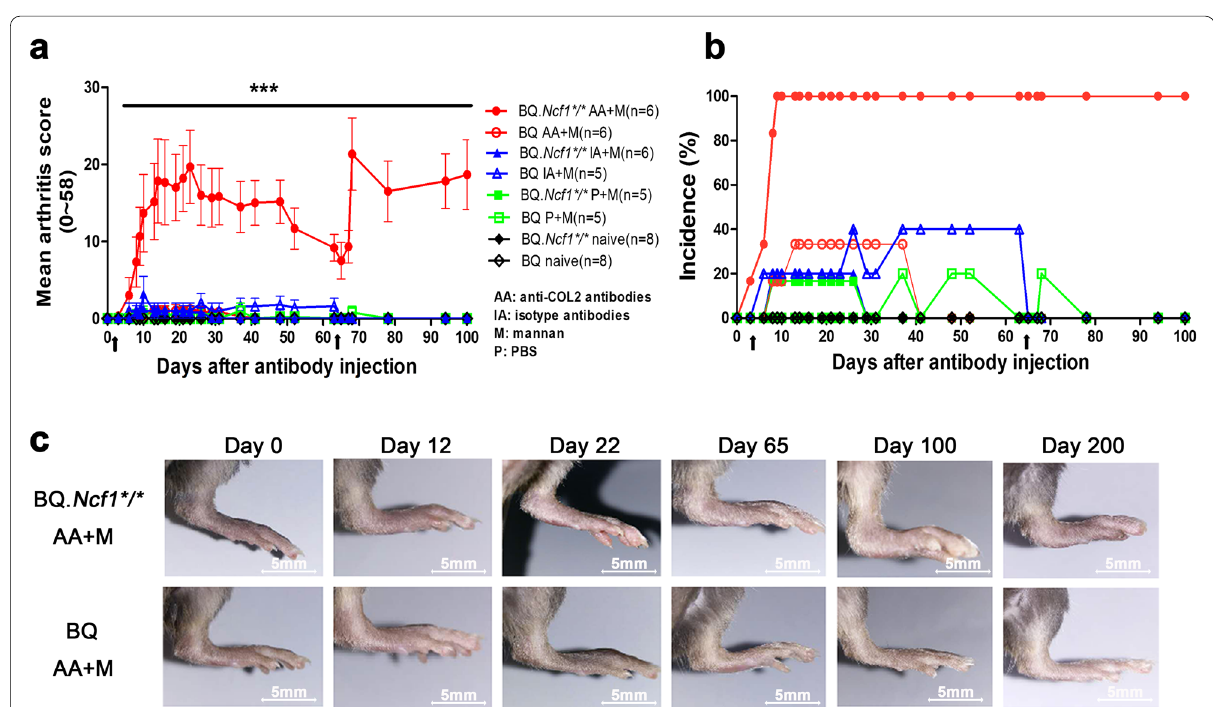
Fig. 1 Chronic arthritis developed in the BQ. Ncf1 */* mice after injection of anti-COL2 antibodies and mannan. BQ. Ncf1 */* mice and BQ mice were i.v. injected with anti-COL2 antibody cocktail containing M2139 (3 mg) as a control on day 0 and 4 mg of mannan was injected i.p. on days 3 and 65. (In this project, we injected anti-COL2 antibodies into 10 BQ. Ncf1 */* mice and 8 BQ mice in total. For other groups, n antibody cocktail injected BQ. Ncf1 */* mice and BQ mice. Black arrows indicate i.p. injection of 4 mg of mannan each time per mouse, total 2 times. The two-tailed Mann-Whitney U test was used to calculate the level of significance. BQ. Ncf1 */* AA mean ±